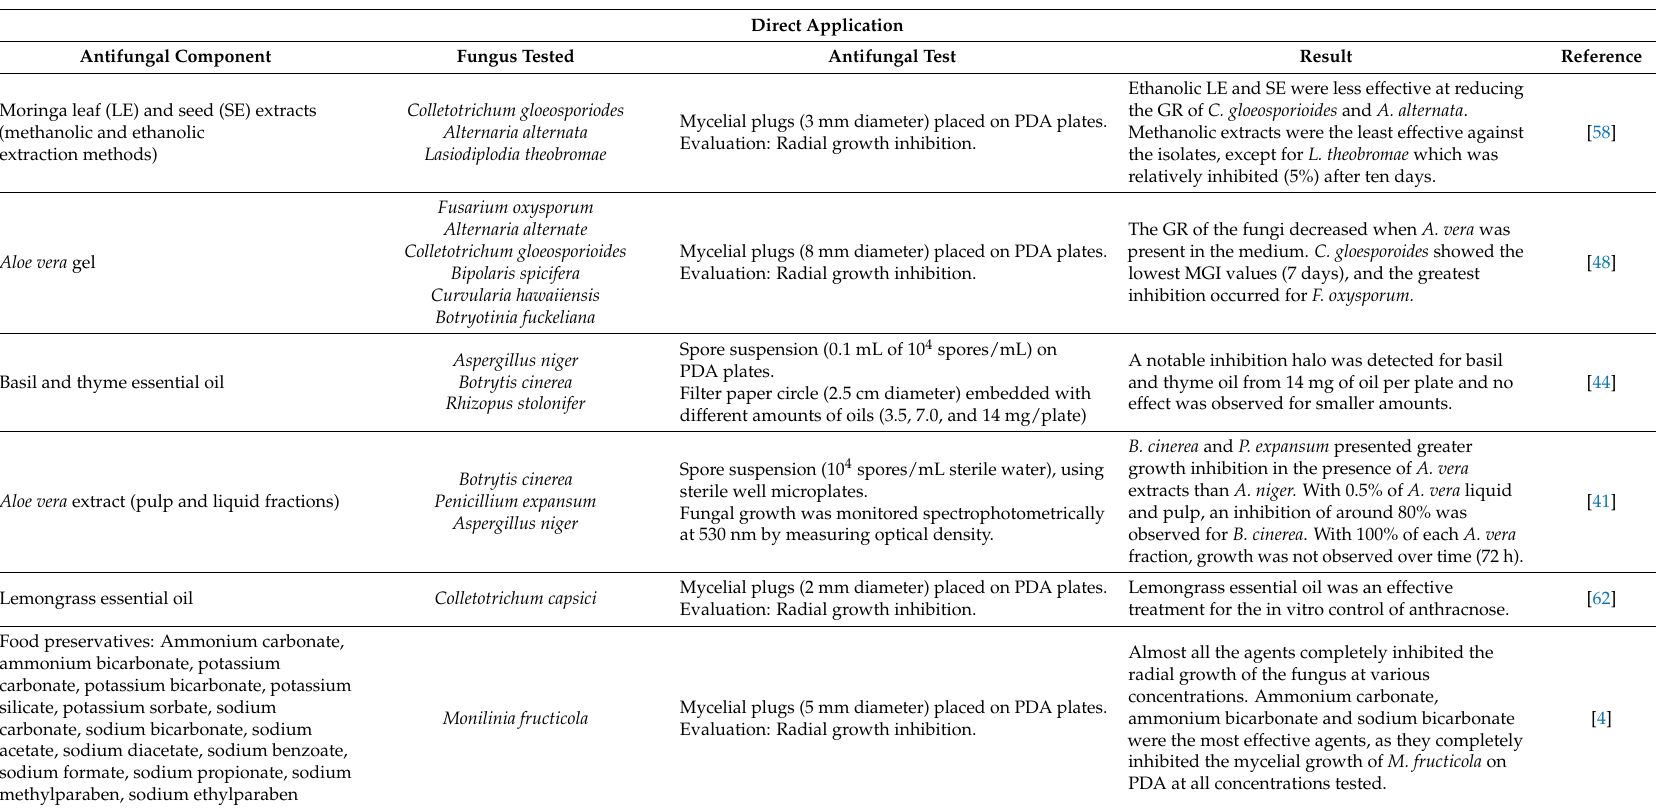
Table 4. Recent studies into natural antifungal compounds with potential use in fruits and